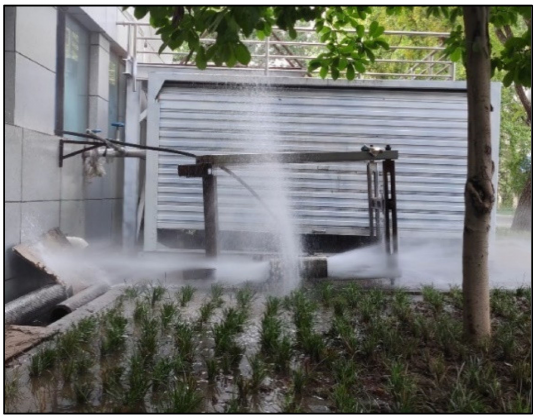
Figure 6. Experiment flushing process.